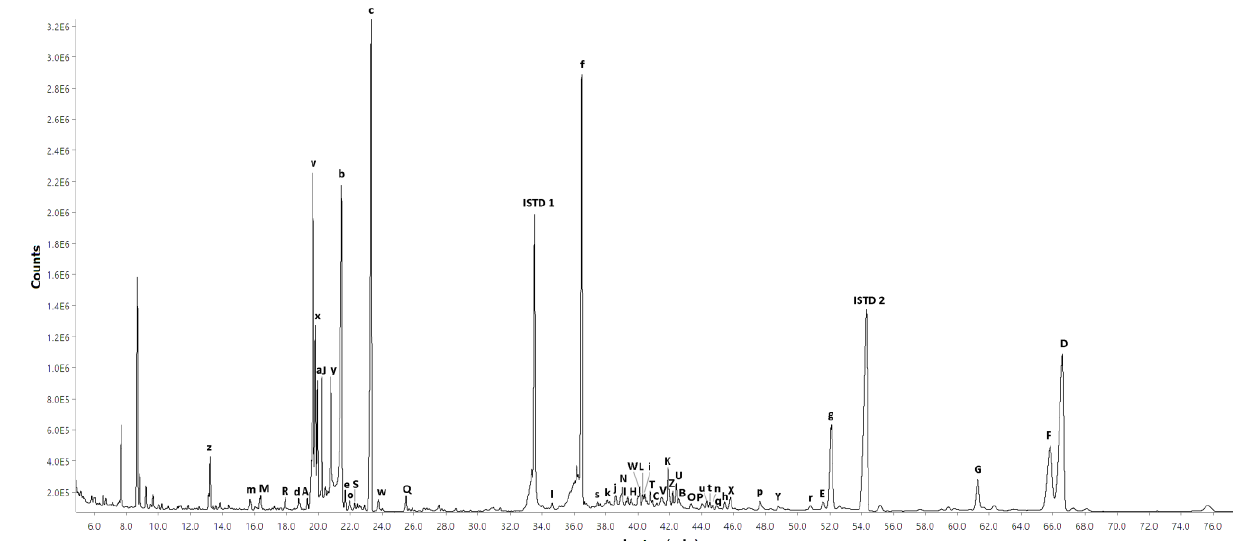
Figure A4. Reference gas chromatography with flame ionisation detection or mass spectrometry (GC-FID/MS) chromato- gram for spruce bark water extract. For alphabetical peak symbols, see Table 4.